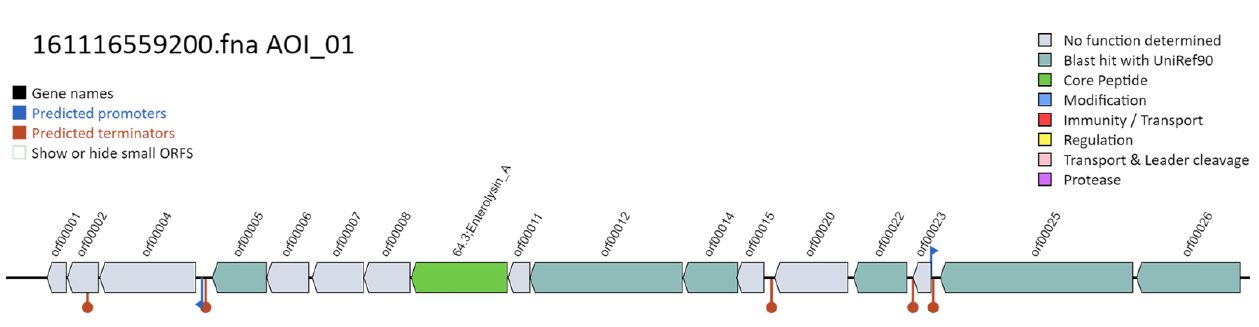
Figure 8. Prediction of a bacteriocin structure in the genome of L. fermentum ATCC 23271 strain. After identifying the cleavage site of the translated bacteriocin protein sequence, using the SignalP 5.0 server, the mature protein was analyzed in silico to predict its antimicrobial activity by using four algorithms, including Support Vector Machine (SVM), Random Forest (RF), Artificial Neural Network (ANN) and Discriminant Analysis (DA). Of these four algorithms, three indicated a high probability (>0.9) of the peptide to present antimicrobial activity (Table 4). Table 4. Prediction of antimicrobial activity by using algorithms of CAMP R3 database.